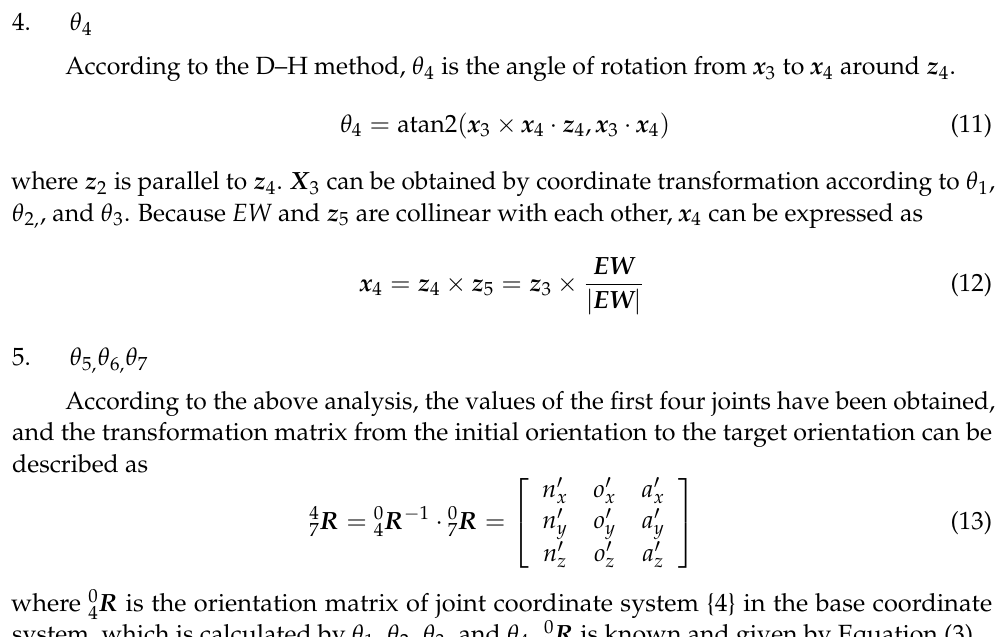
Figure 6. Position of the elbow E.